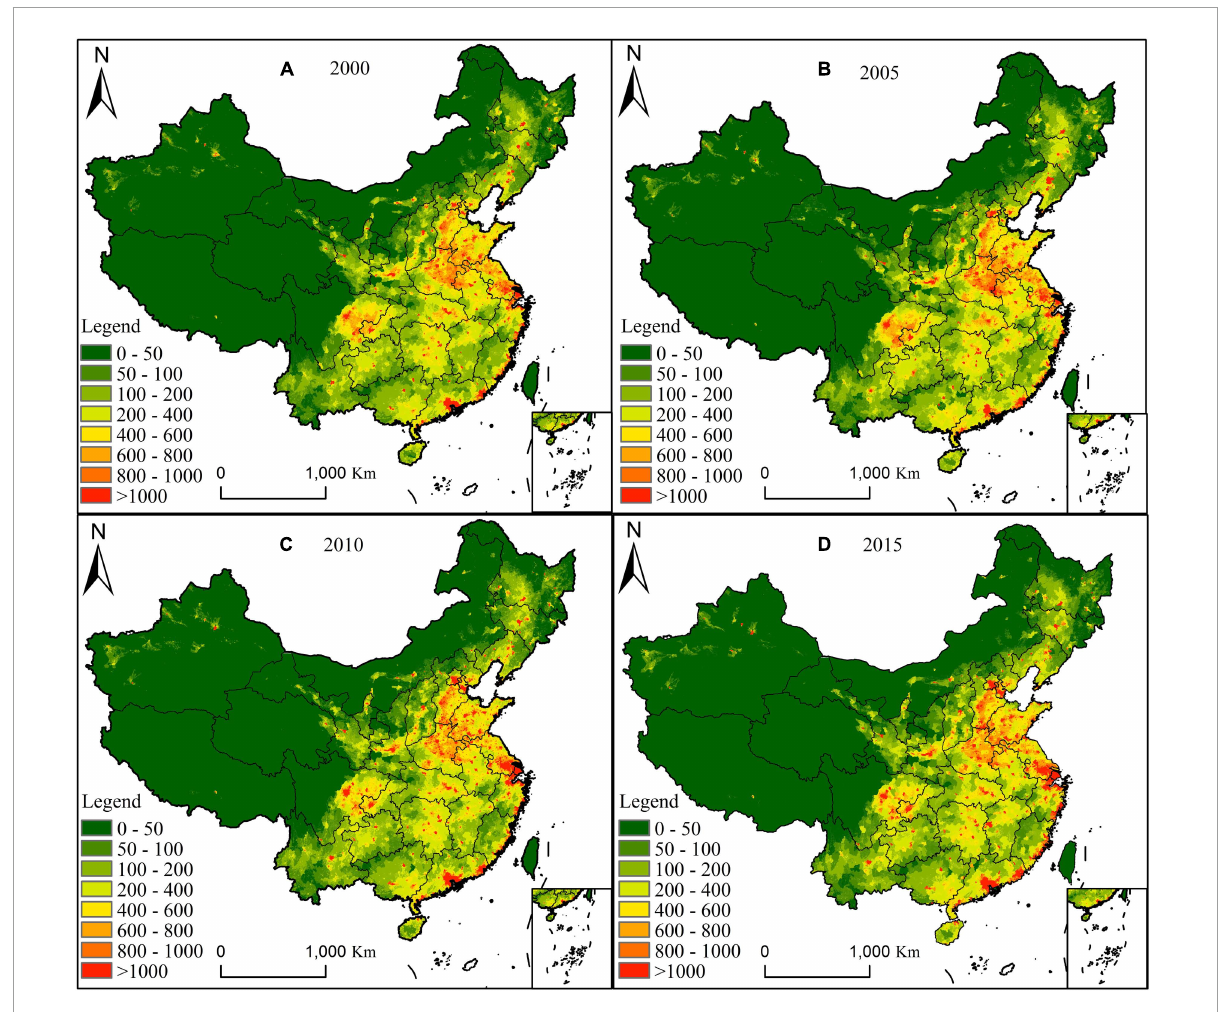
FIGURE5 Spatial distribution of population density in China from 2000 to